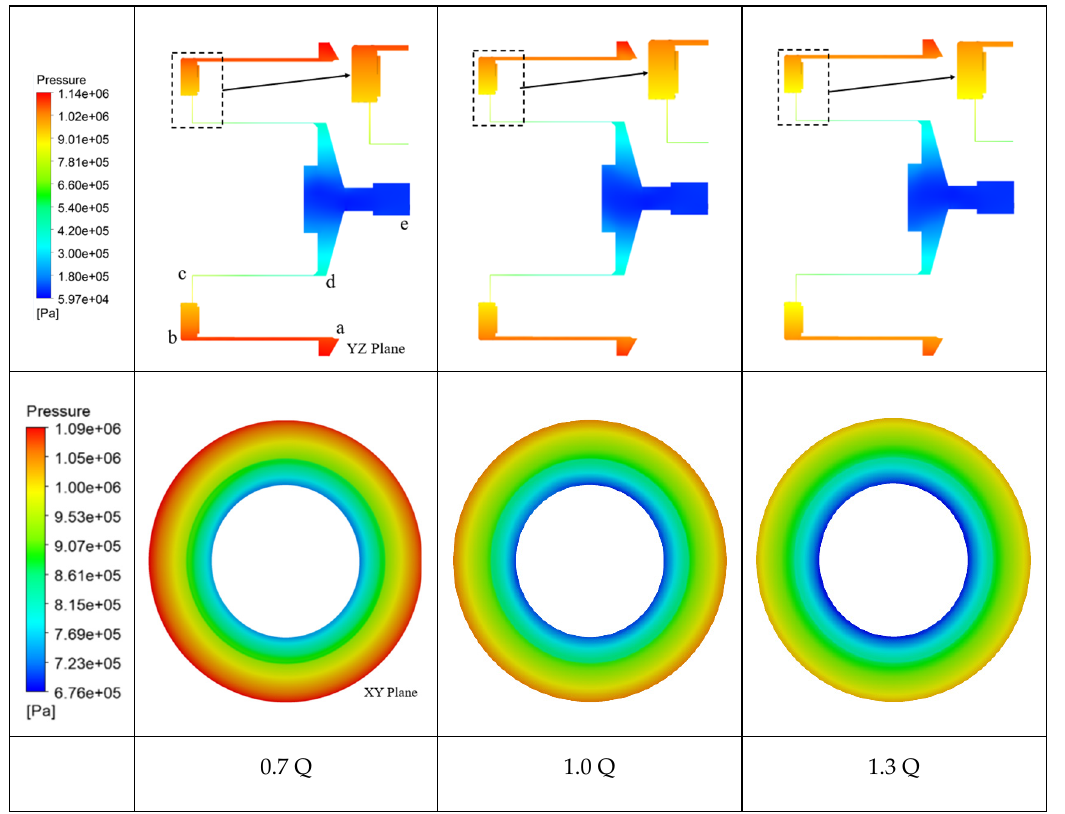
Figure 11. Pressure distribution of the cooling circuit.